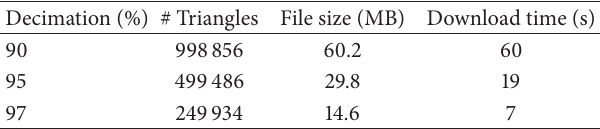
Table 4: Number of triangles, X3D file size, and download time of three meshes generated after different decimation based on the original cave chamber model with 10 038 522 faces.